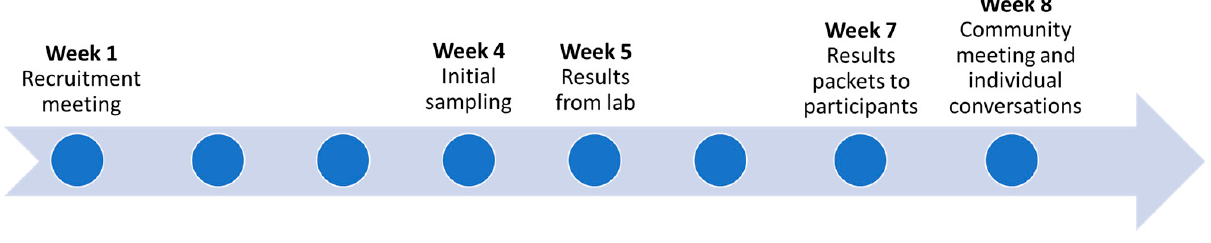
Figure 1. Timeline for results communication.